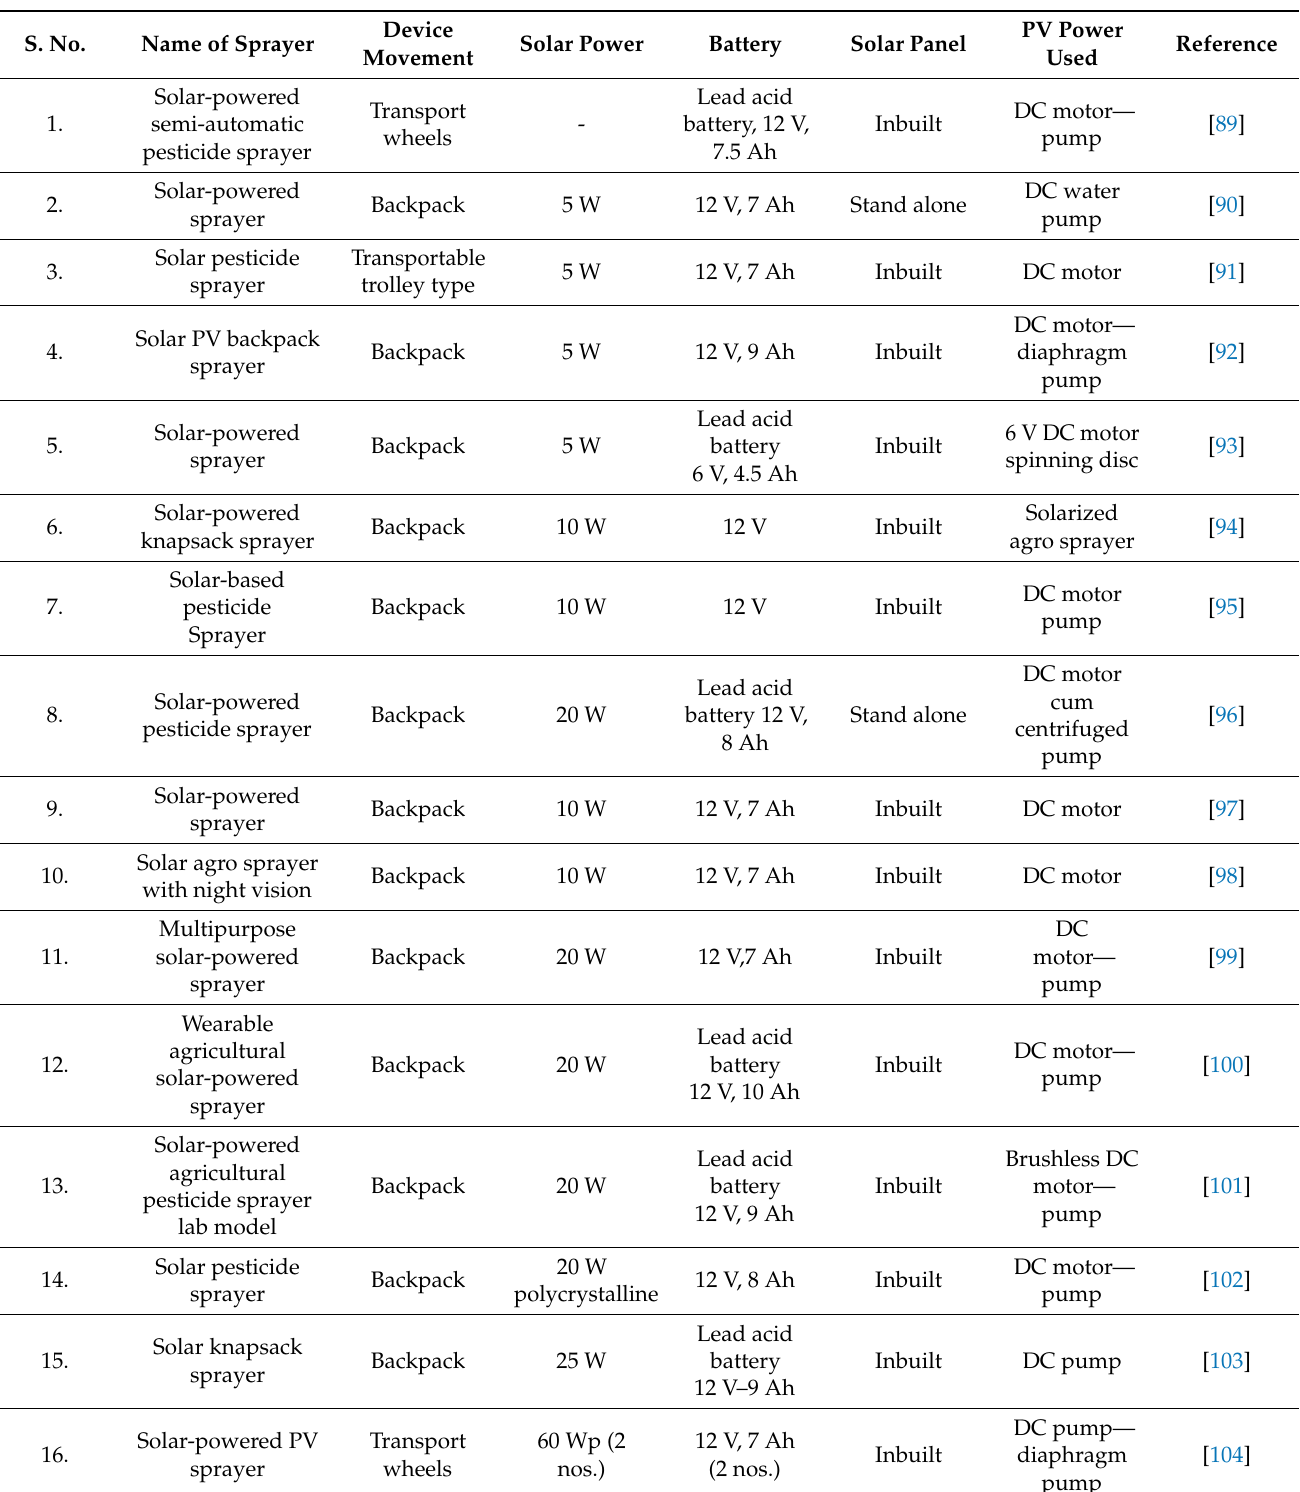
Table 3. Details of the various types of solar-powered